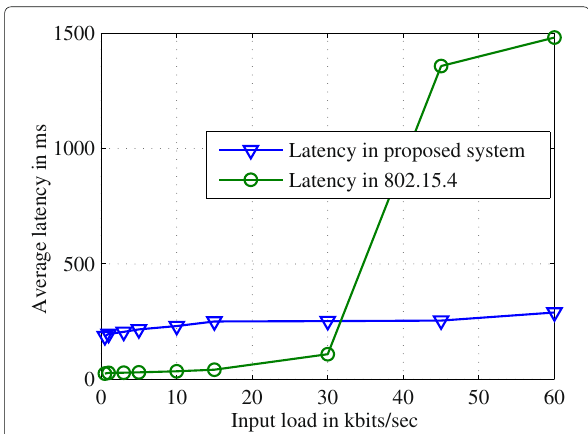
Fig. 12 Network latency for different input traffic loads